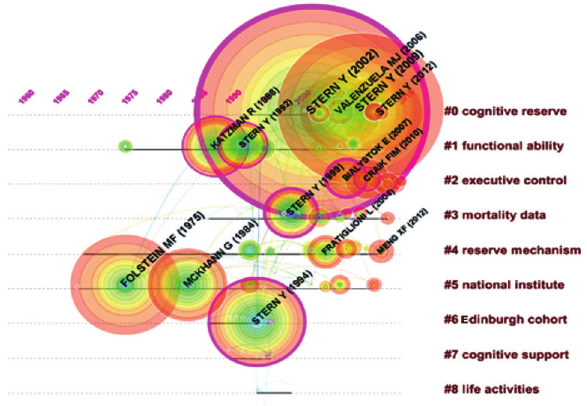
Figure 2. Timeline of co-citation clusters. Landmark articles are